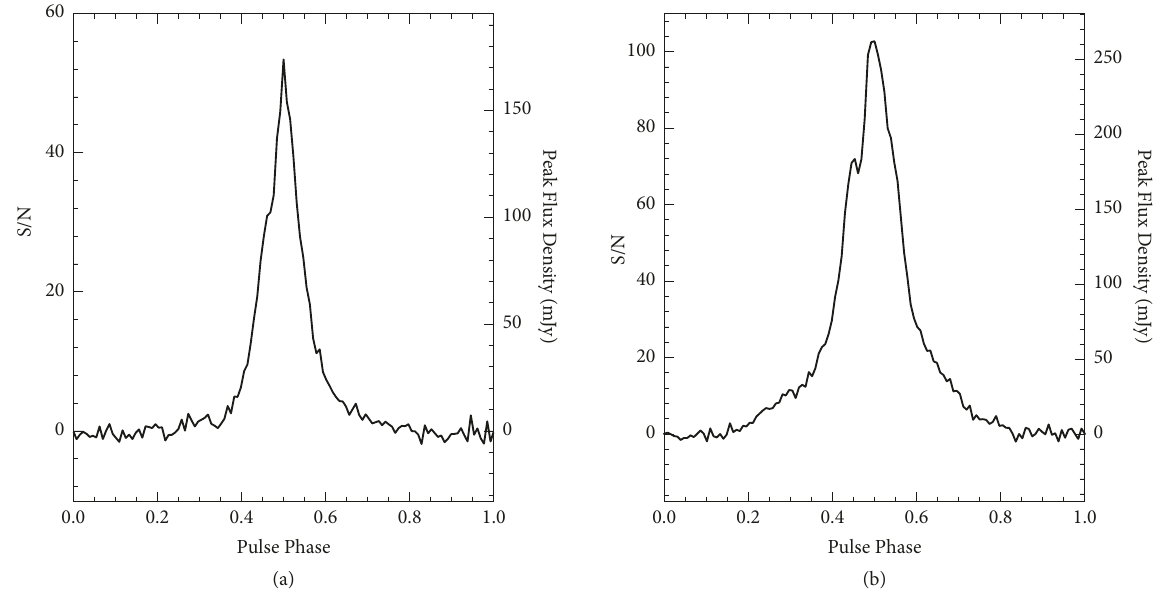
Figure 7: Average 𝑆 -band pulse profiles of the radio magnetar, PSR J1622–4950, obtained using the 34 m radio telescopes near Canberra, Australia on (a) 2018 April 26 and (b) 2018 May 10. Additional details on these observations will be presented in Pearlman et al.